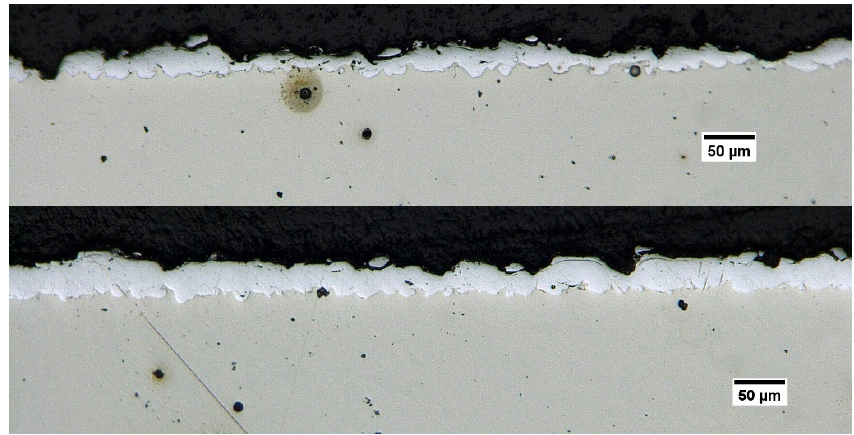
Figure 14. Optical micrographs showing cross sections of cold spray deposits for unprocessed Cr (top) and dried Cr (bottom).